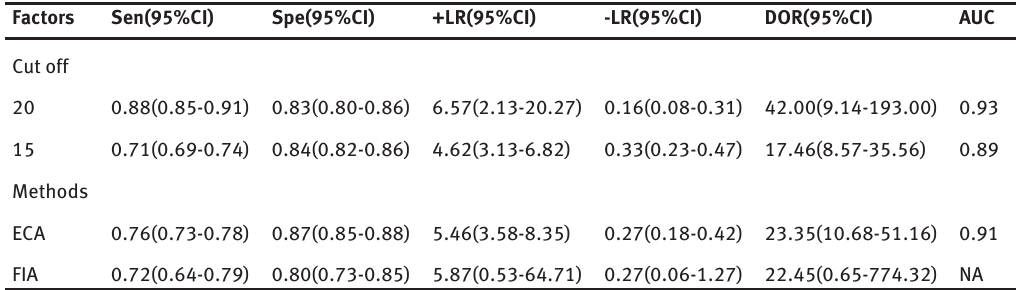
Figure 6: Summary Receiver Operating Characteristic (SROC) cure of serum Hcy as biomarker in diagnosis of DN. Table 3: Subgroup analysis according to the cut off value and Hcy detection